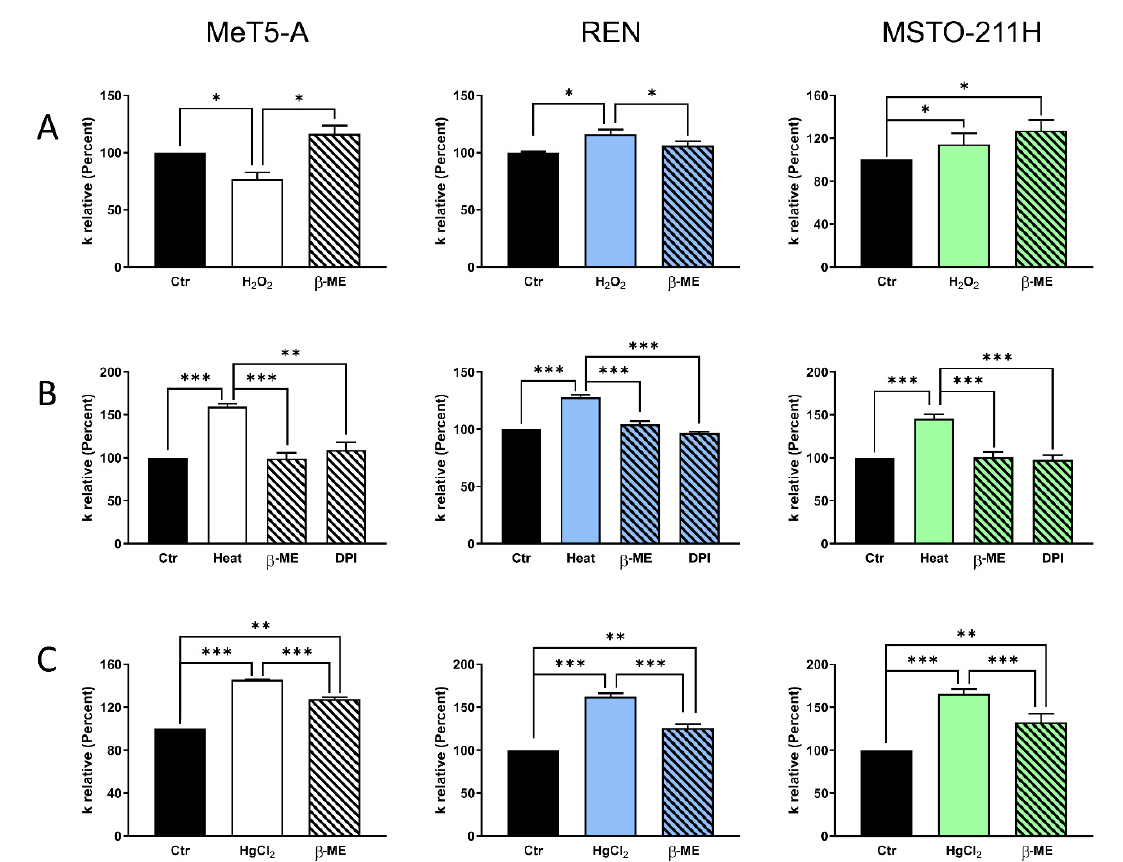
Figure 5. Effect of oxidative stress ( A , B ) and mercury ( C ) on the water permeability of mesothelial cells (MeT-5A), epithelioid (REN), and biphasic (MSTO-211H) MPM cells. ( A ) Cells were exposed to 150 mOsm osmotic gradients in three different conditions: untreated cells (Ctr), cells treated with H 2 O 2 (H 2 O 2 ), and cells treated with β -mercaptoethanol after H 2 O 2 treatment ( β -ME). ( B ) Cells were exposed to 150 mOsm osmotic gradients in four different conditions: untreated cells (Ctr), heat-stressed cells (Heat), cells treated with β -mercaptoethanol after heat stress ( β -ME), and cells treated with diphenyleneiodonium chloride (DPI) before heat stress (DPI). ( C ) Cells were exposed to 150 mOsm osmotic gradients in three different conditions: untreated cells (Ctr), cells treated with mercury chloride (HgCl 2 ), and cells treated with β -mercaptoethanol after HgCl 2 treatment ( β -ME). *, p < 0.05; **, p < 0.01; ***, p < 0.001. Bars represent the osmotic water permeability of MeT-5A cells expressed as a percent of k relative. Values are means ± SEM of 4–15 single shots for each of 4